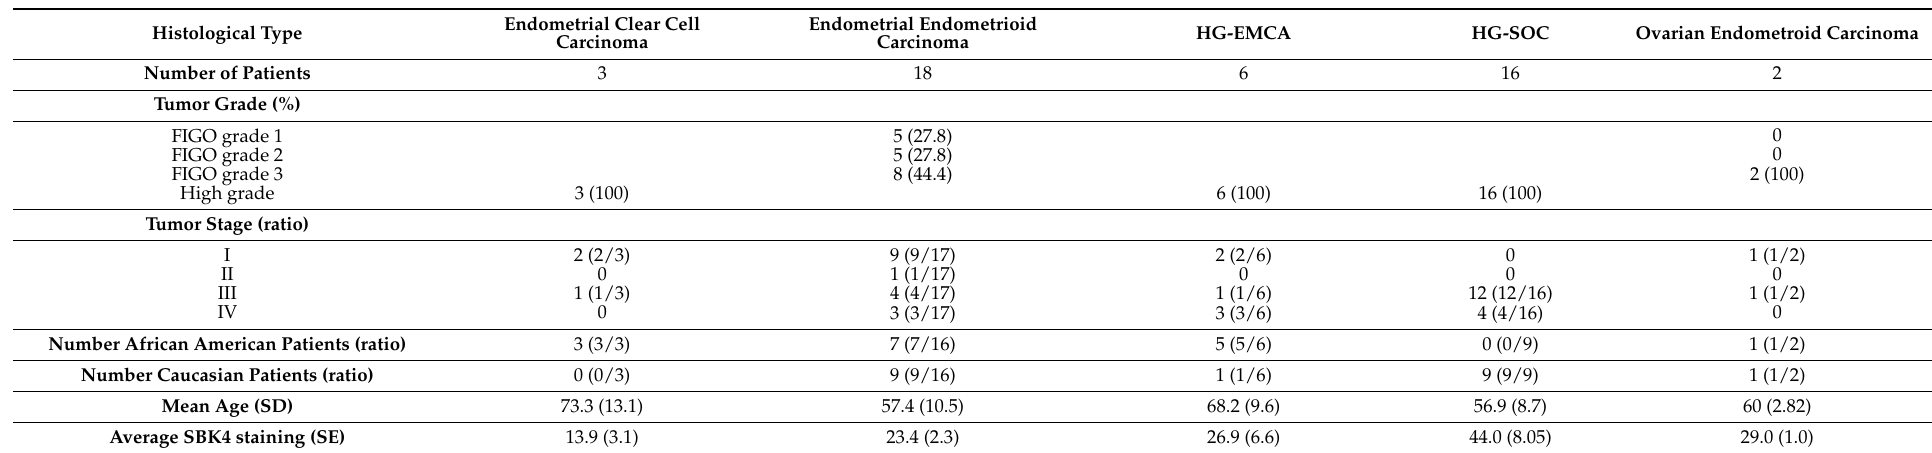
Table 2. Clinicopathological characteristics of gynecological cancer patient